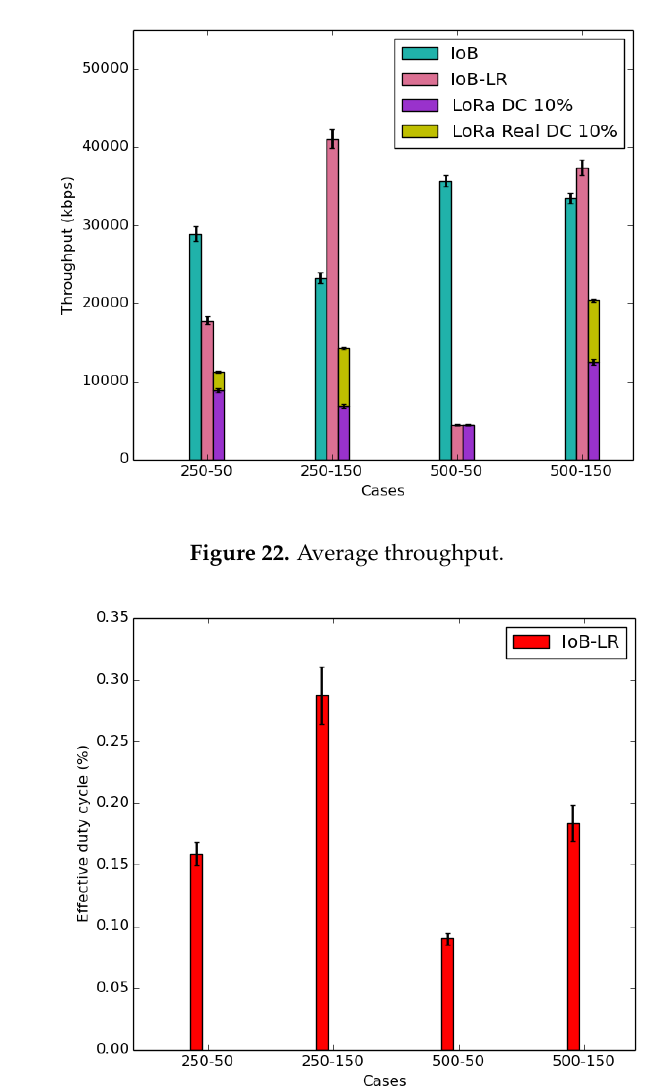
Figure 23. Average effective duty